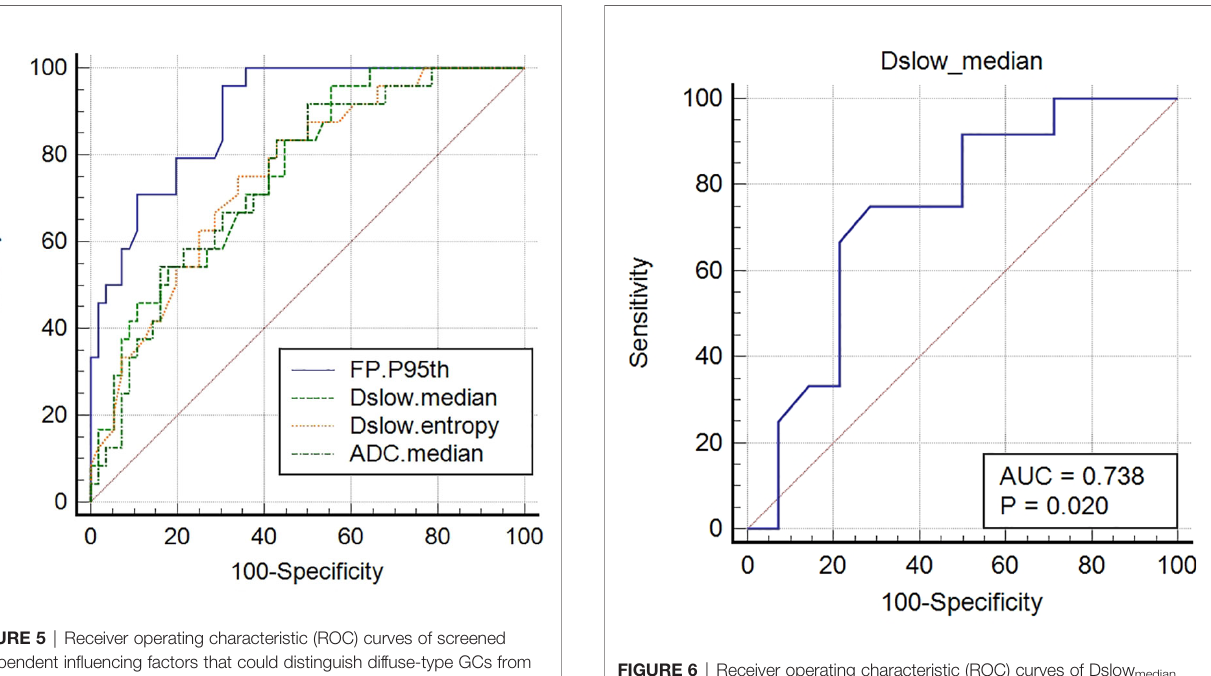
FIGURE 6 | Receiver operating characteristic (ROC) curves of Dslow median for distinguishing signet-ring cell carcinomas from other poorly cohesive carcinomas. The AUC of Dslow median was